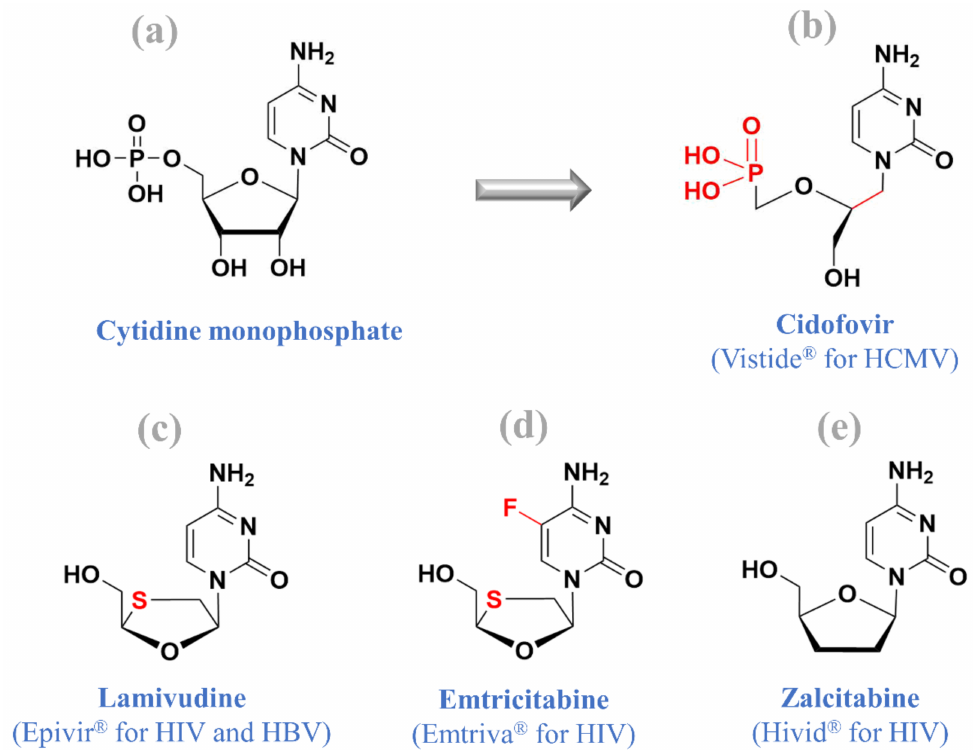
Figure 5. Cytidine monophosphate ( a ) and four approved cytidine nucleos(t)ide analogues: ( b ) cidofovir, ( c ) lamivudine, ( d ) emtricitabine, and ( e )